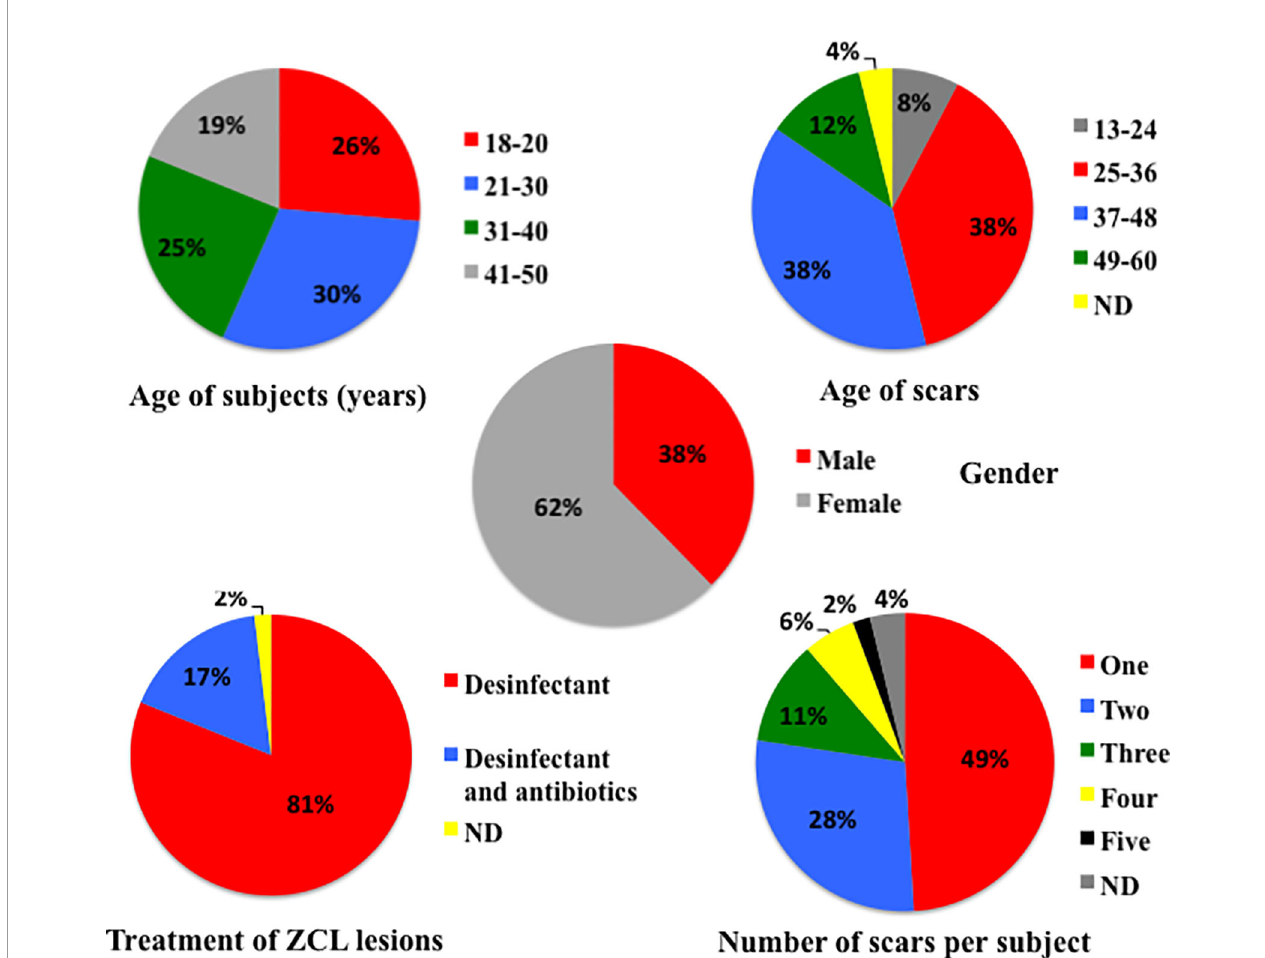
FIGURE 2 | Age, gender, and number of scars of healed-patient distribution; age and localization of scars distribution; and nature of treatment taken during the zoonotic cutaneous leishmaniasis by the 53 patients included in this study and from whom biopsies of scars were